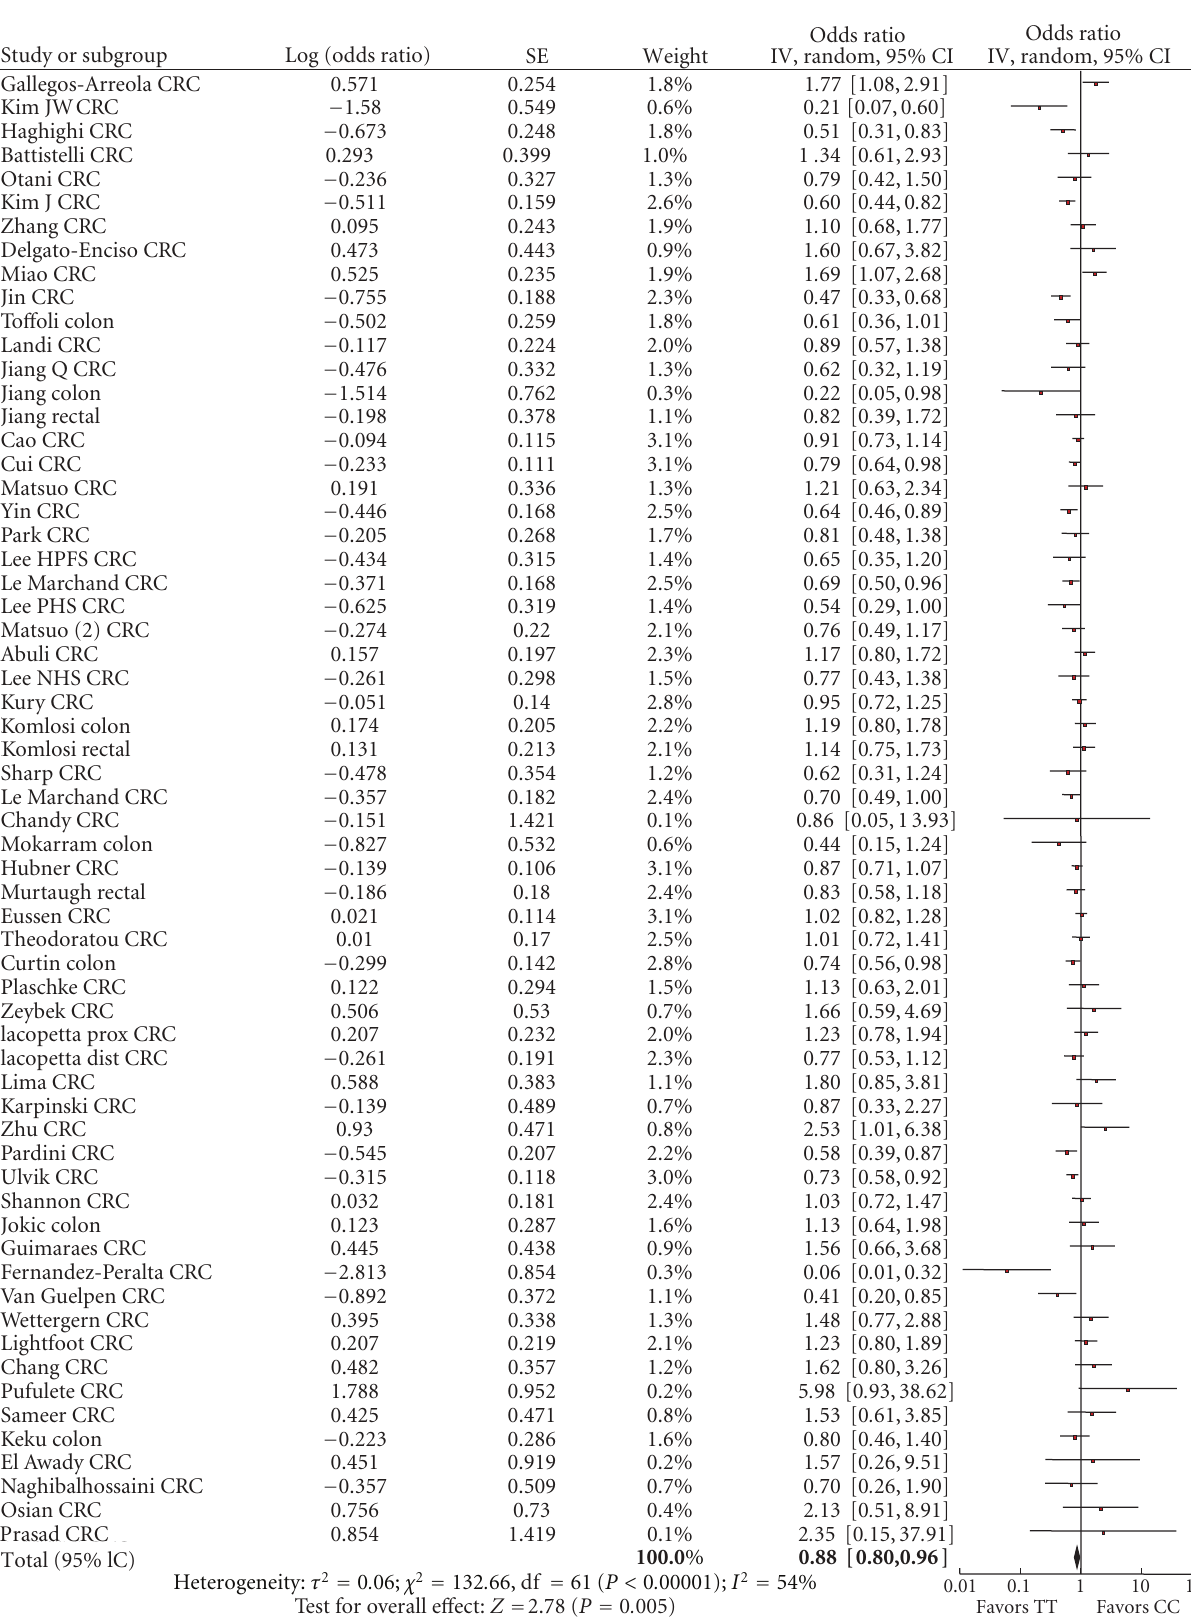
Figure 3: Forest plot of the risk of colorectal cancer for MTHFR 677 TT versus